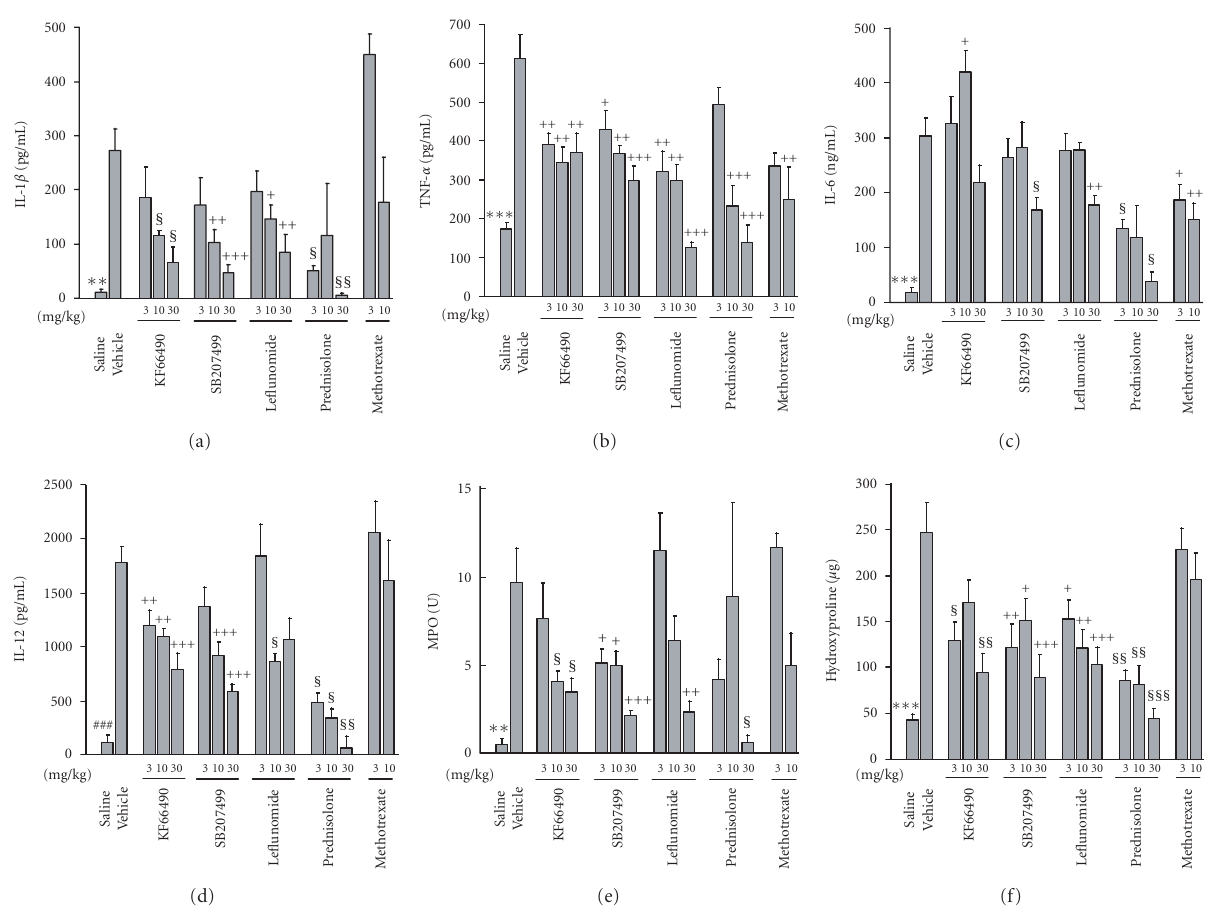
Figure 2: E ff ects of antirheumatic drugs and a PDE4 inhibitor on the mBSA-induced granuloma. Drugs were orally administered once a day from day 0 to 10. On day 11, the granuloma was collected and cultured for 24 h at 37 ◦ C. Cytokine concentrations in the supernatants and MPO activity and hydroxyproline content in the mixture of the culture medium and the granuloma were measured. PDE4 inhibitors, KF66490 (3, 10, 30mg/kg) and SB207499 (3, 10, 30mg/kg), leflunomide (3, 10, 30mg/kg), prednisolone (3, 10, 30 mg/kg), and methotrexate (3, 10 mg/kg) were orally administered. IL-1 β (a), TNF- α (b), IL-6 (c), IL-12 (d), MPO activity (e), and hydroxyproline content (f). Results are shown as the mean ± SE of 6 to 10 mice. ###: P < . 001 (The Student’s t test), ∗∗ P < . 01, ∗∗∗ P < . 001 (Aspin-Welch test), +: P < . 05, ++: P < . 01, +++: P < . 001 (Dunnett test), § : P < . 05, §§ : P < . 01, §§§ : P < . 001 (Steel test). Representative data from three independent experiments are